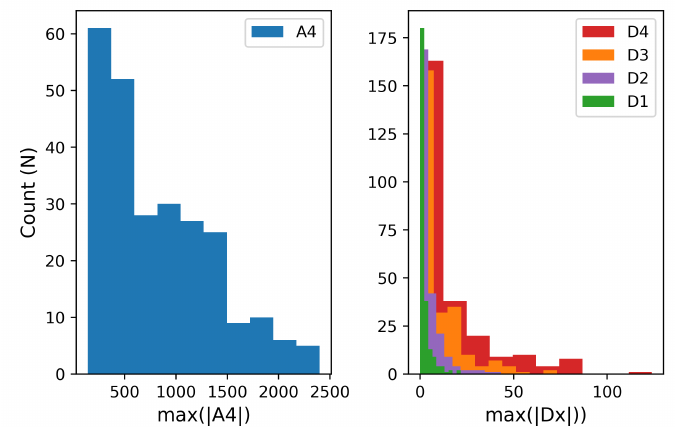
Figure 6. The distribution of wavelet coefficient values for the approximation vector, A 4 , and detail coefficients, D 4 − D 1 , that compose the 1D wavelet transformation, W 4 . A total of 253 EDA signals were transformed using the ML-DWT algorithm and, for each signal, the maximum magnitude of the wavelet coefficient was recorded. This distribution is used to define the maximum bits required to store the wavelet